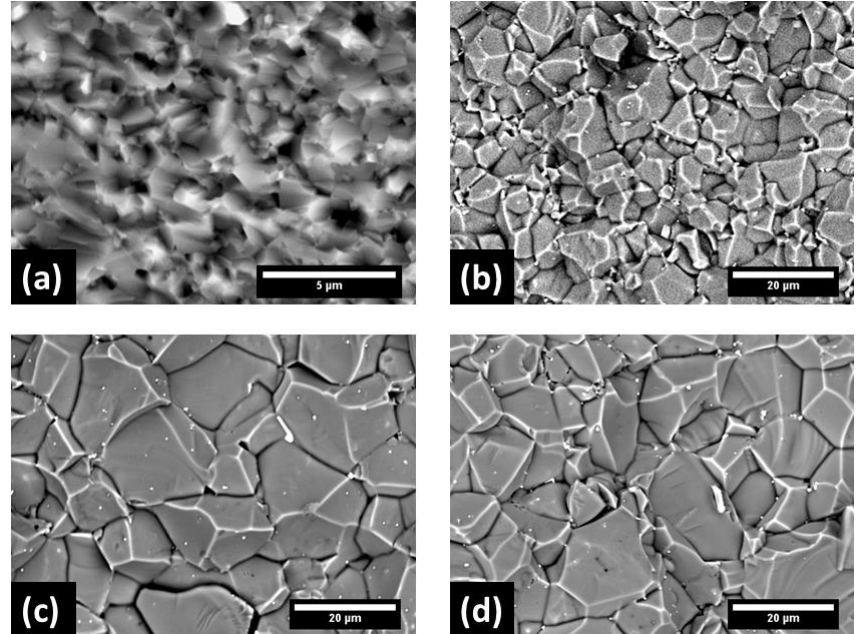
Figure 5. Scanning electron micrographs of the fracture surfaces after spark plasma sintering at 1400 °C. The images were recorded in a BSE mode from ( a ) additive-free sample, and the samples doped with 0.5 wt% of ( b ) LiF, ( c ) MnF , and ( d ) CoF 2 . 0.5 wt% of ( b ) LiF, ( c ) MnF, and ( d ) CoF 2 .